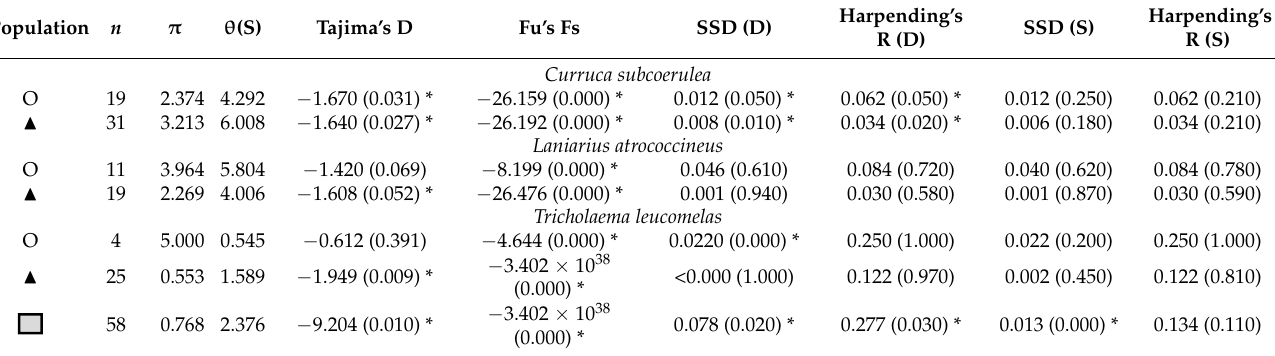
Table 1. Population genetic estimates for each of the three species evaluated, and for which we have provided the statistics for each of the population scenarios tested (explained in detail in text). π and θ (S) are diversity estimators for each population, while Tajima’s D and Fu’s Fs are used to assess demographic neutrality, where a statistically significant p -value for a negative value suggests population expansion. Both SSD and Harpending’s R statistic are measures relating to mismatch distributions. We evaluated both demographic and spatial scenarios (D, S); a statistically non-significant p -value provides support for an expansion scenario, while a statistically significant p -value supports population stability. p -values are in parentheses, and statistical significance (a ≤ 0.05) is indicated by an *.